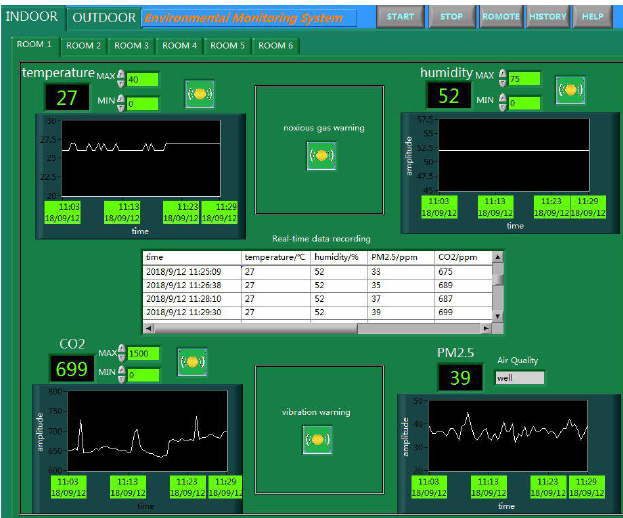
Figure 13. The client system.